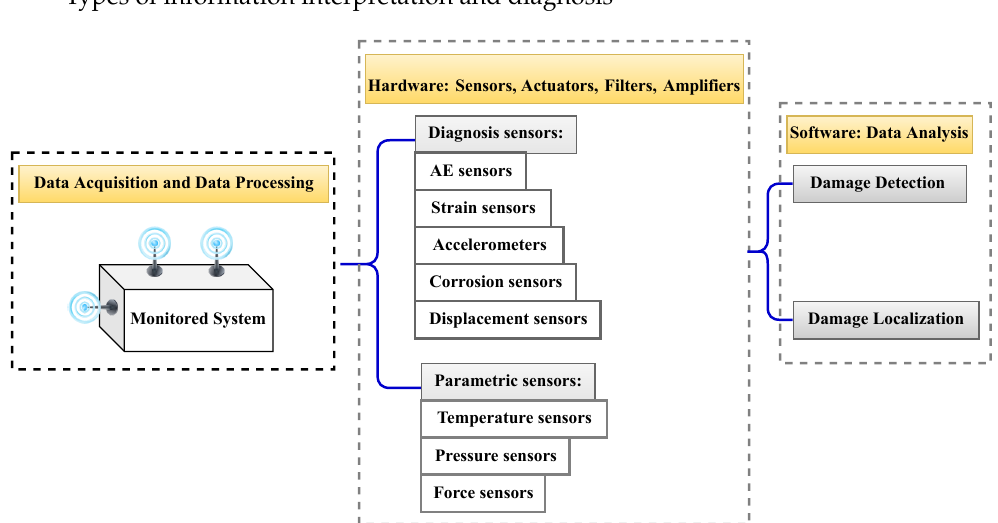
Figure 4. Components of SHM